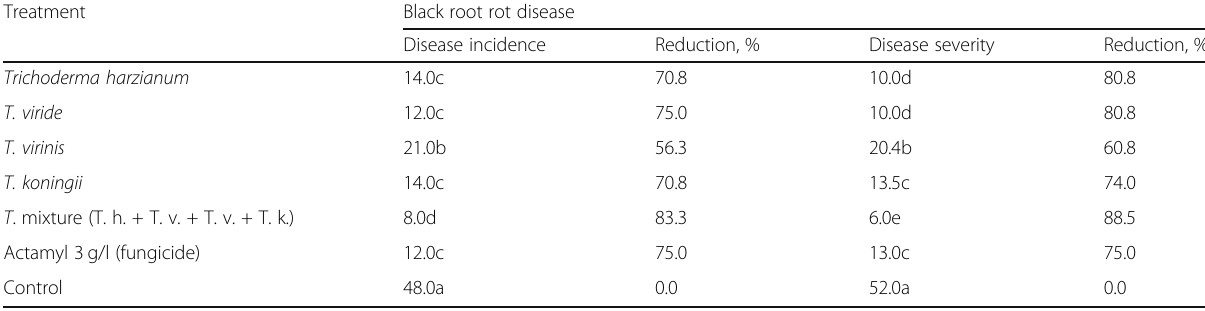
Table 2 Effect of four Trichoderma spp. on black root rot disease of strawberry plants under field conditions